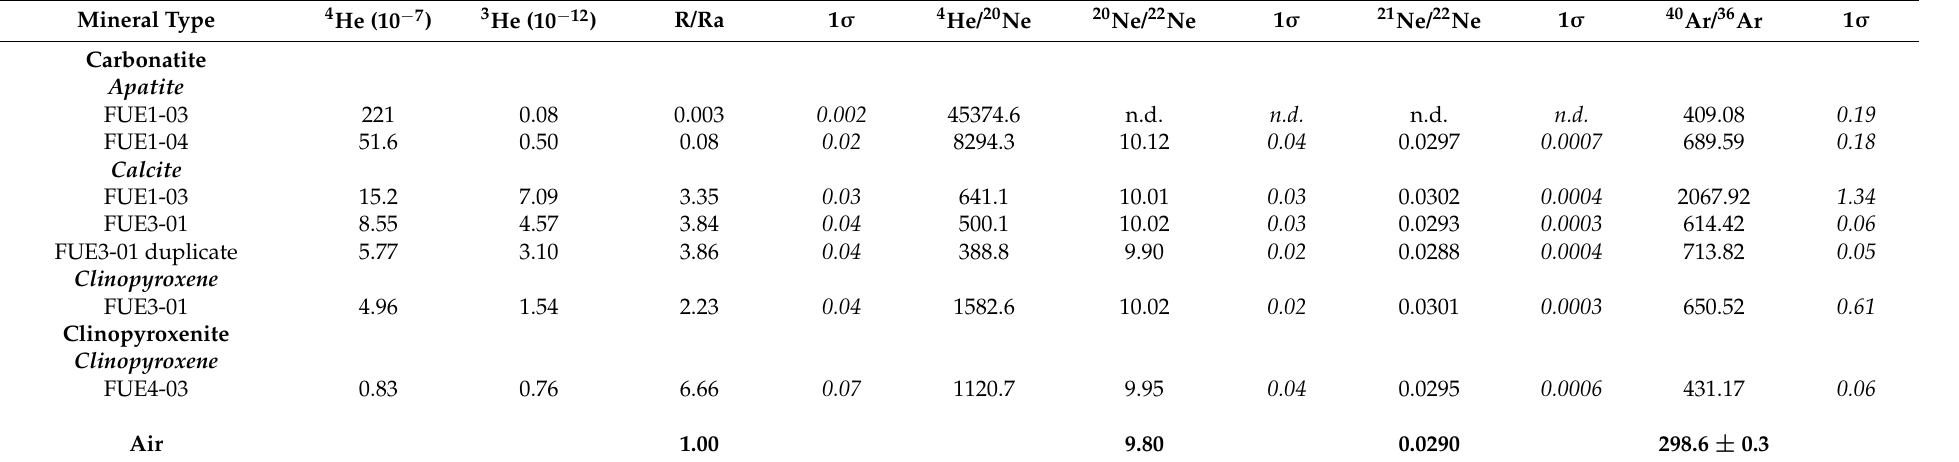
Table 5. He concentrations (ccSTP/g) and He, Ne, and Ar isotopic ratios in mineral separates from Fuerteventura carbonatites and